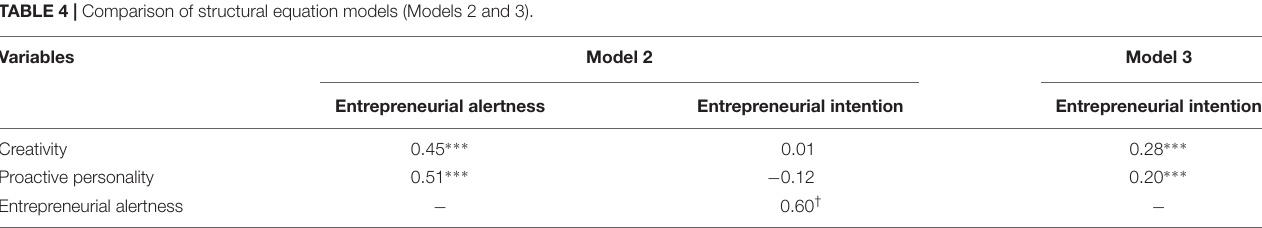
Model 3: creativity + proactive personality → entrepreneurial intention (without mediator). † Marginal significant. ∗∗∗ p <